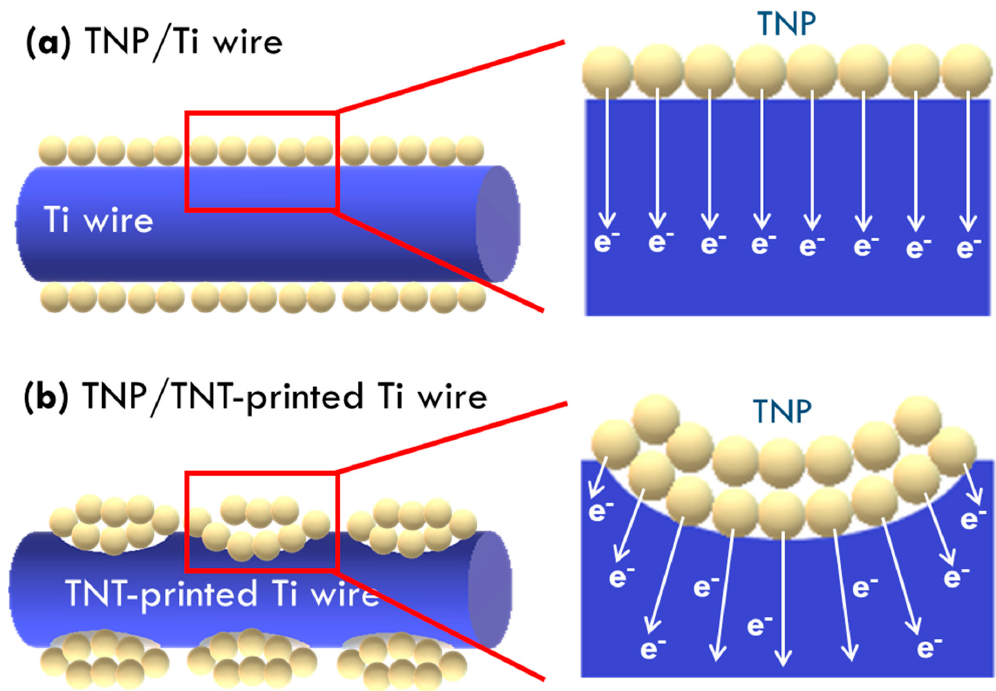
Figure 6. ( a ) IMPS spectra, ( b ) IMVS spectra and ( c ) relation of the transport time, lifetime, and collection efficiency to anodization voltage for preparing the substrate of photoanodes for FDSSC with TNP/Ti wire and TNP/TNT-printed Ti wire